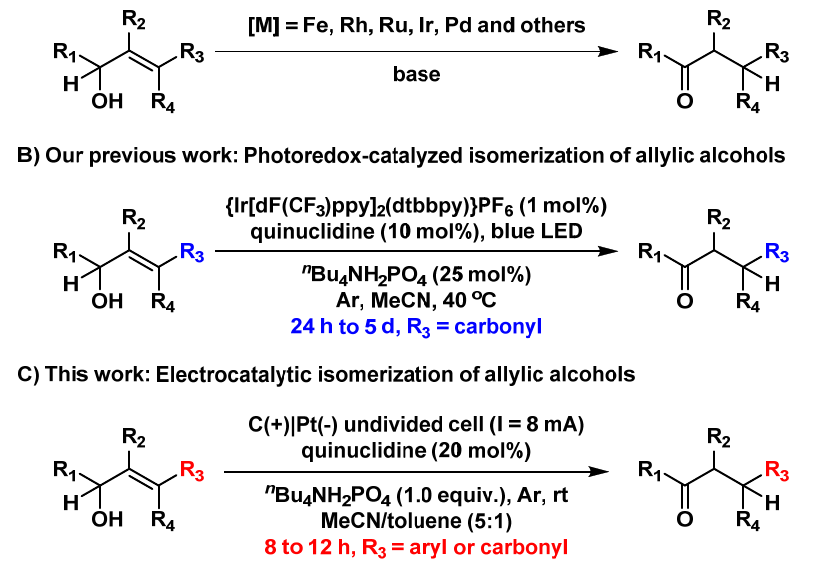
Figure 1. Representative bioactive molecules containing β -aryl-ketones.